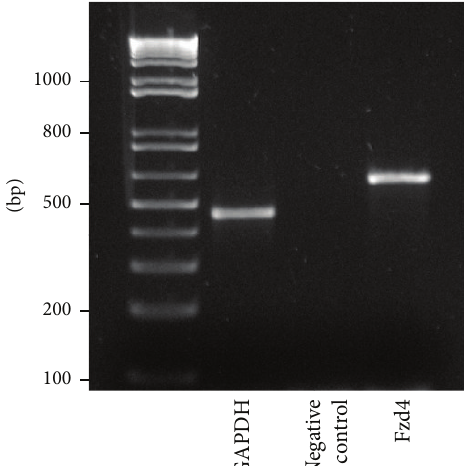
Figure 4: Identification of frizzled-4 (Fzd4) mRNA by RT-PCR. Total RNA was isolated from tunica muscularis. Respective primer pairs were used for detection of Fzd4 (605 bp) and the housekeeping gene GAPDH (452bp). Isolated RNA without subsequent reverse transcriptase step served as negative